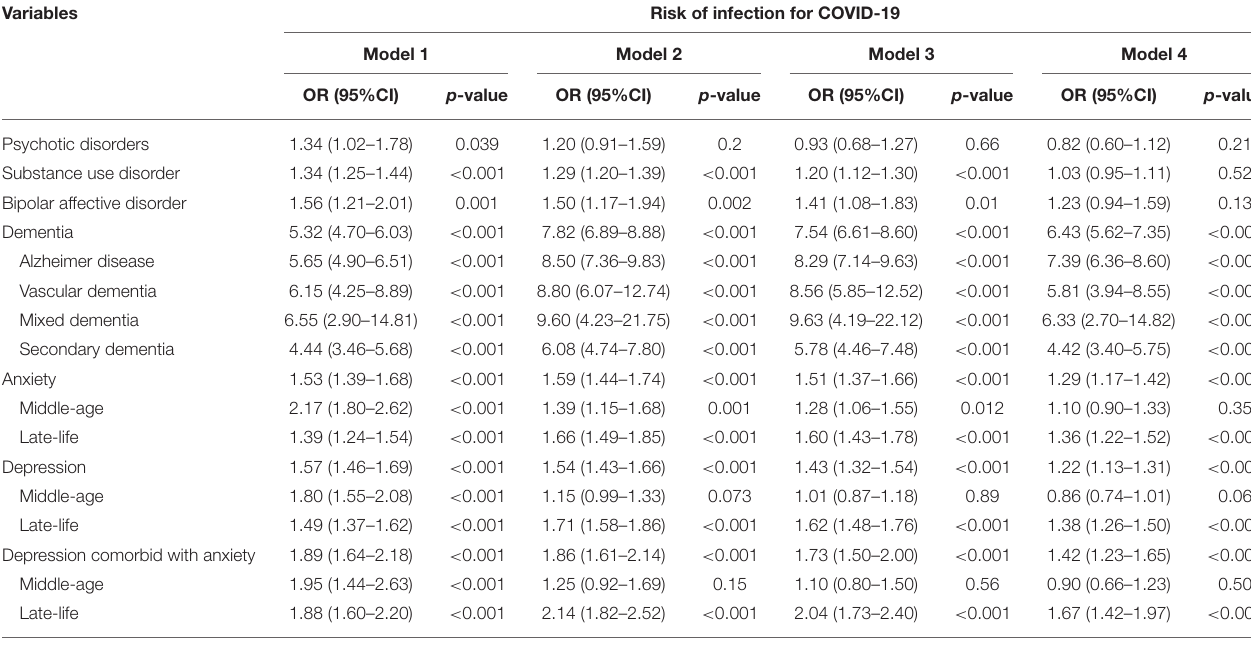
TABLE 2 | Logistic regression analysis of the association between mental disorders and risk of COVID-19.